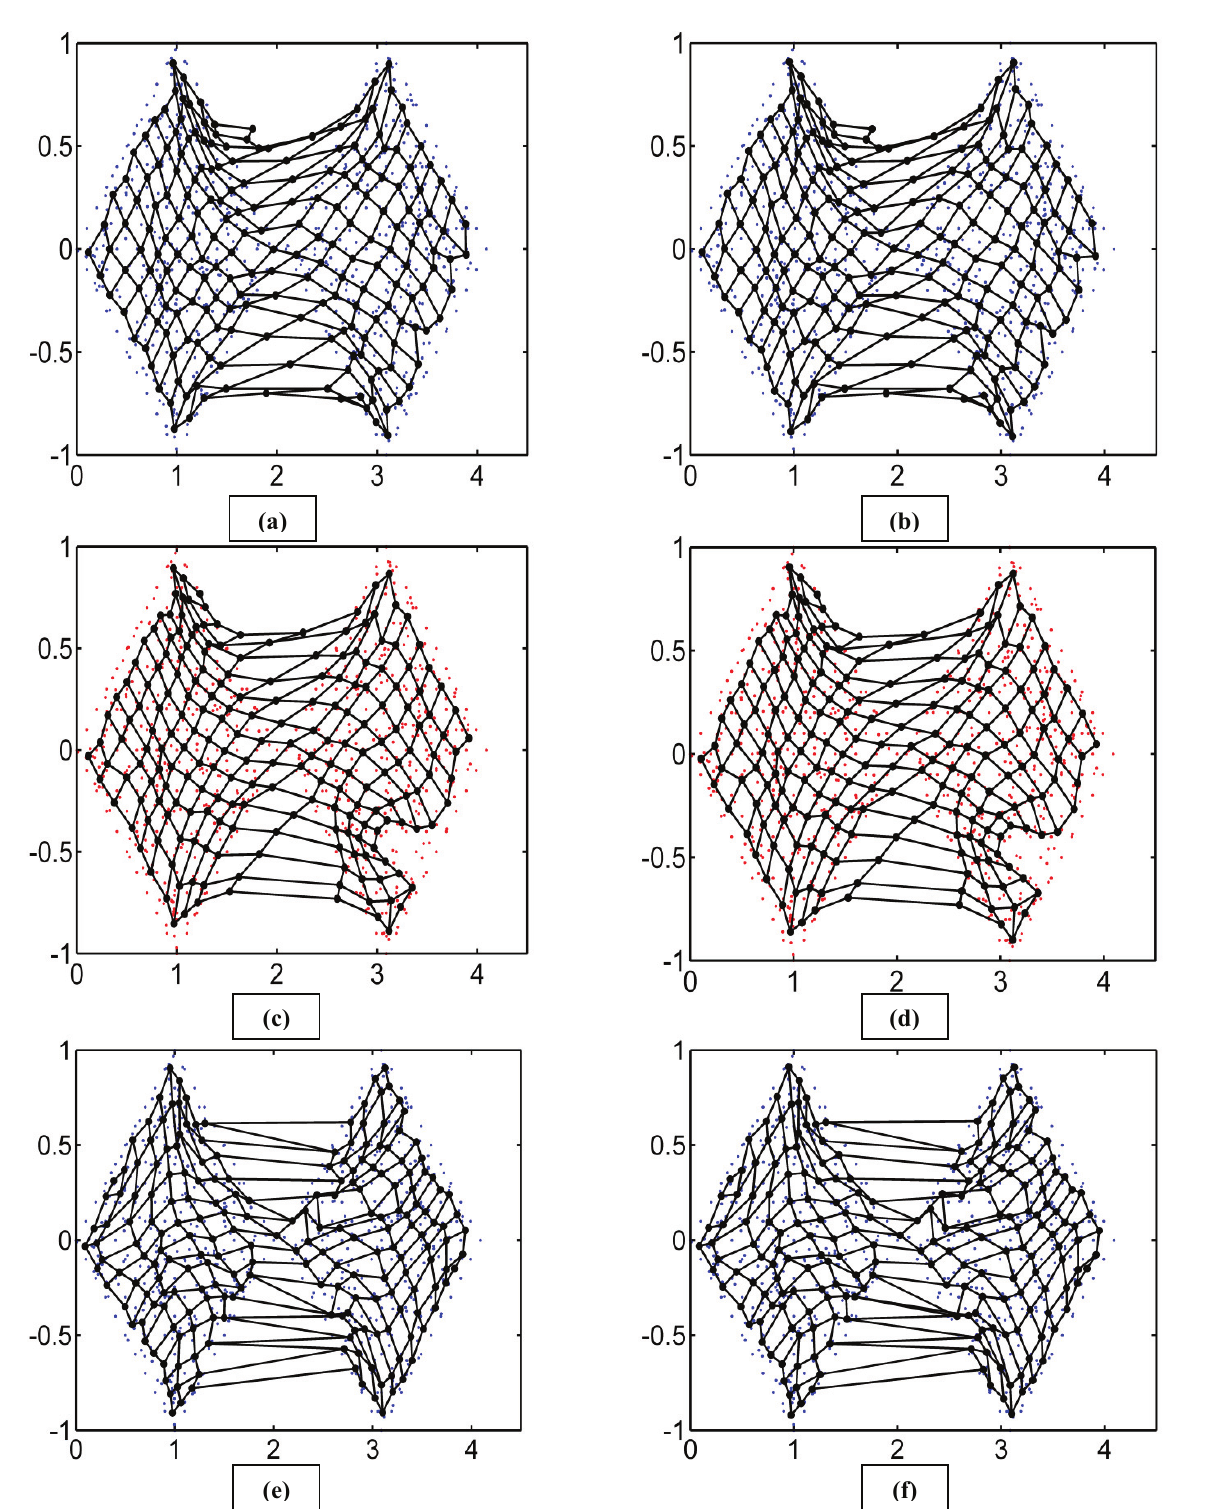
Fig. 4. Snapshots of the trained map of SOM, FN-SOM and E-SOM using linear initialization for map size 15*14 in Experiment 2. (a) Conventional SOM (ten epochs) (b) Conventional SOM (twenty epochs) (c) FN-SOM (ten epochs) (d) FN-SOM (twenty epochs) (e) Efficient SOM (ten epochs) (f) Efficient SOM (twenty